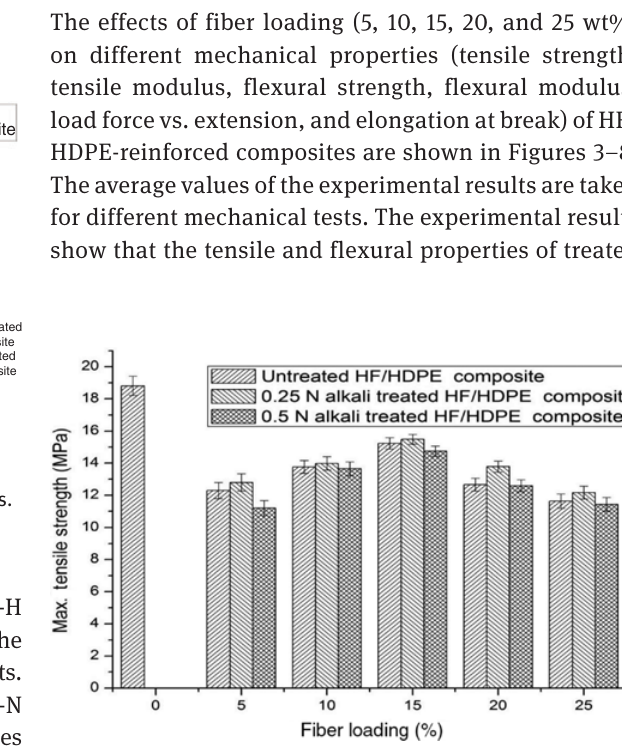
Figure 3: Effect of fiber loading on the tensile strength of HF/HDPE- reinforced composites.